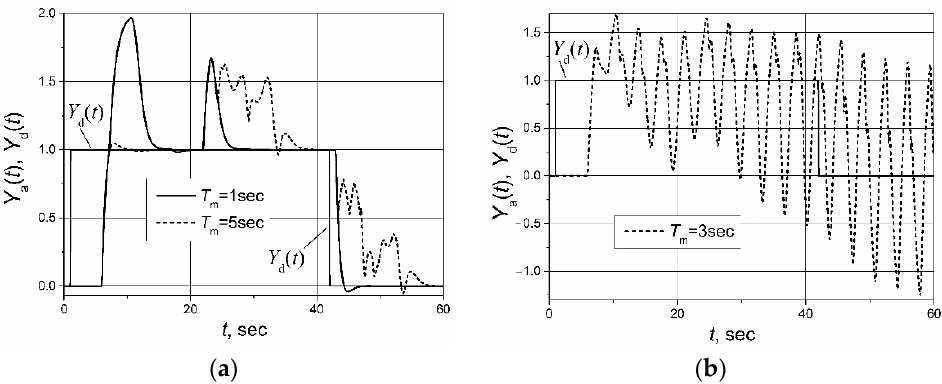
Figure 4. The set-point unit-pulse and unit-load disturbance-response of the control system of the first-order plant with the transfer function G p (s) = 1/(s + 1) and asymmetric response delay ( T r = 5 s, T f = 1 s) based on the PI controller with the classical Smith predictor when ( a ) the delay of the model is adjusted for the values T m = T r = 5 s and T m = T f = 1 s, ( b ) the delay of the model adjusted for the values T m = ( T r + T f )/2 = 3 s. Unit-load disturbance occurs at the time moment t = 17 s.